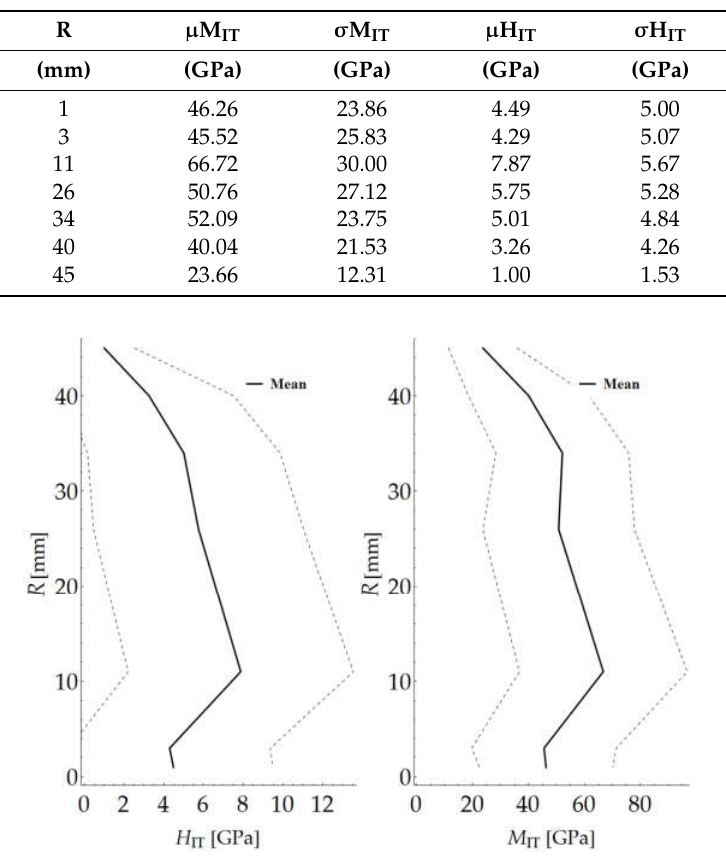
Table 1. Mean values and standard deviations of measured hardness HIT and indentation modulus MIT.